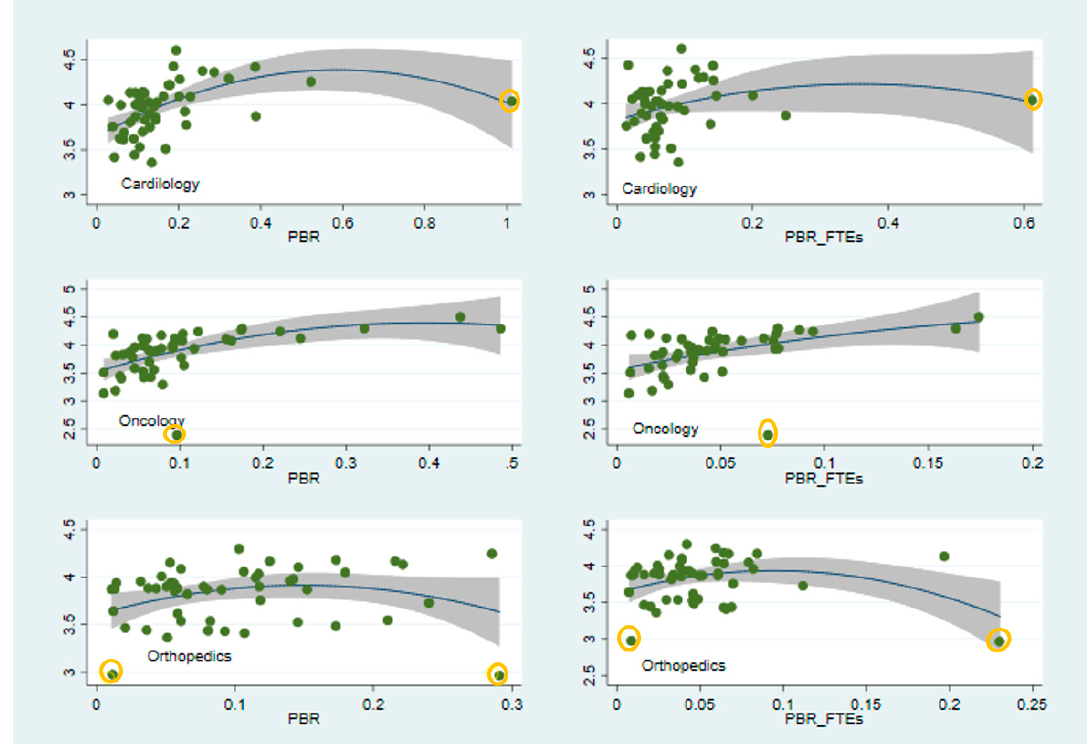
Figure 1. Predicted vs. observed values of ln( IHQ ) as a function of PBR and PBR_FTEs. Predicted ln( IHQ ) are in solid black lines. Observed ln( IHQ ) are in green dots. Shaded areas represent 95% confidence intervals. All other variables are held at means.